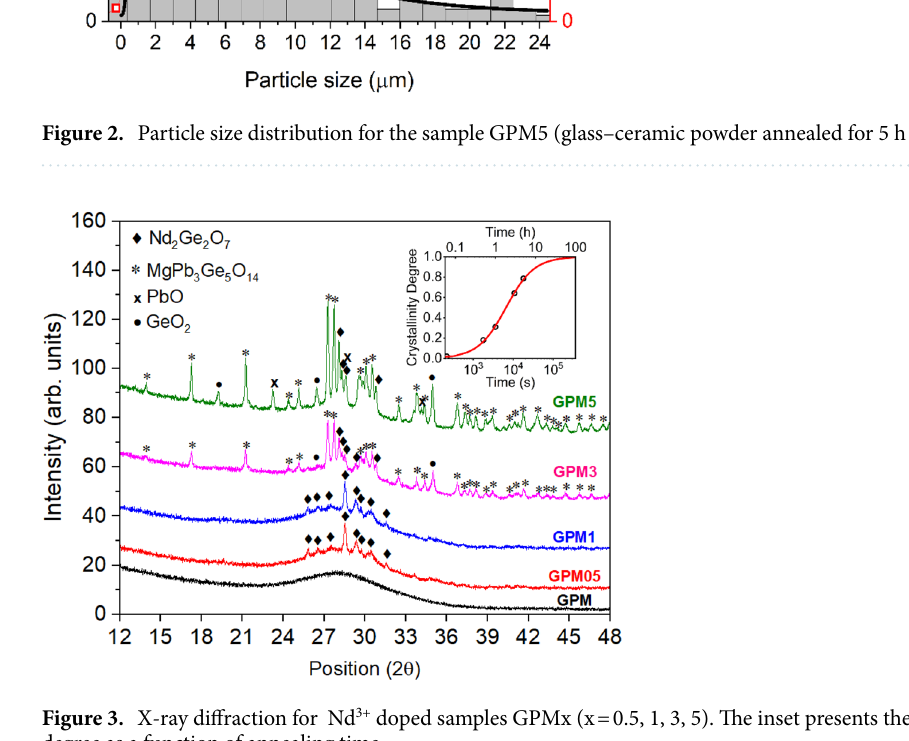
Figure 3. X-ray diffraction for Nd 3+ doped samples GPMx (x = 0.5, 1, 3, 5). The inset presents the crystallinity degree as a function of annealing